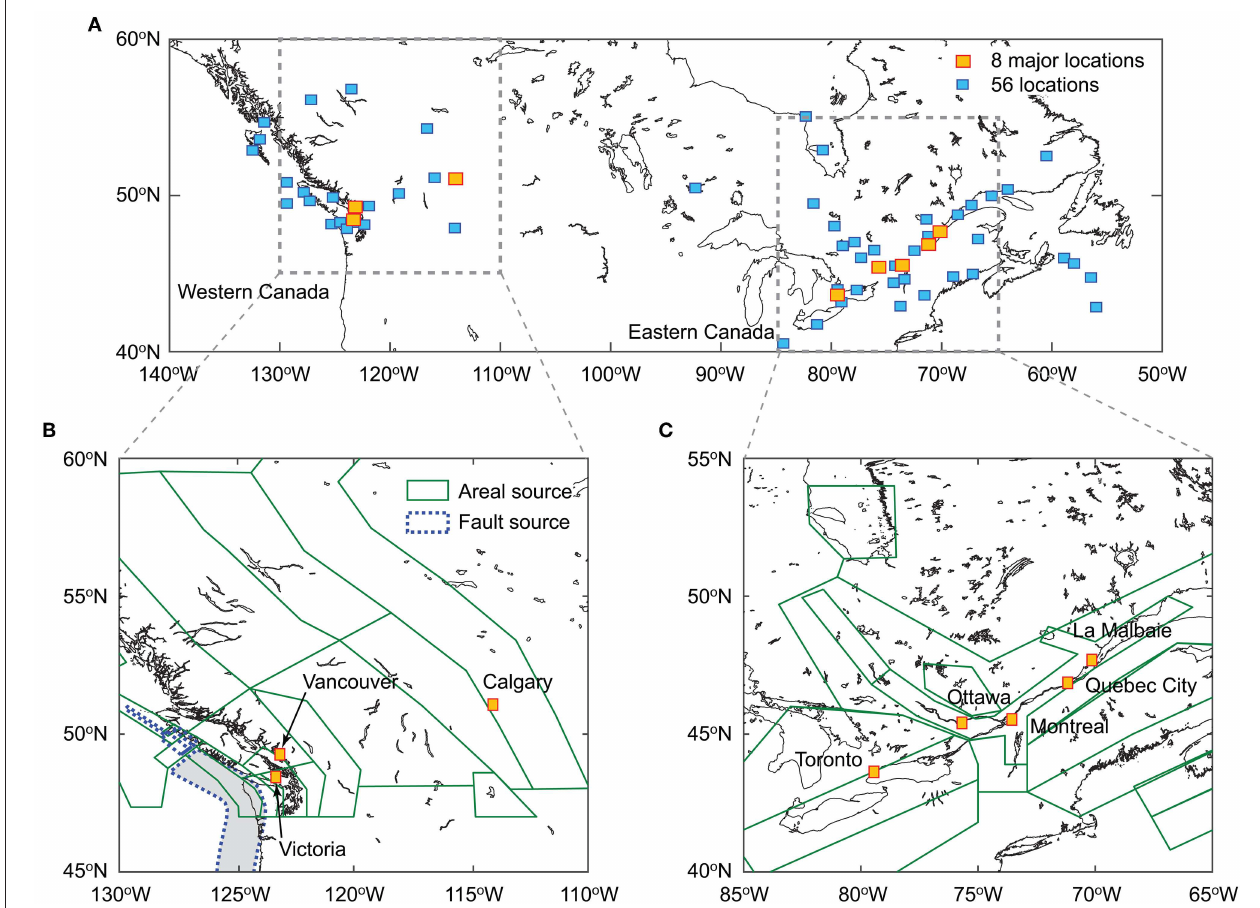
FIGURE 2 | (A) Map of Canada, (B) seismic source zones for western Canada, and (C) seismic source zones for eastern Canada.